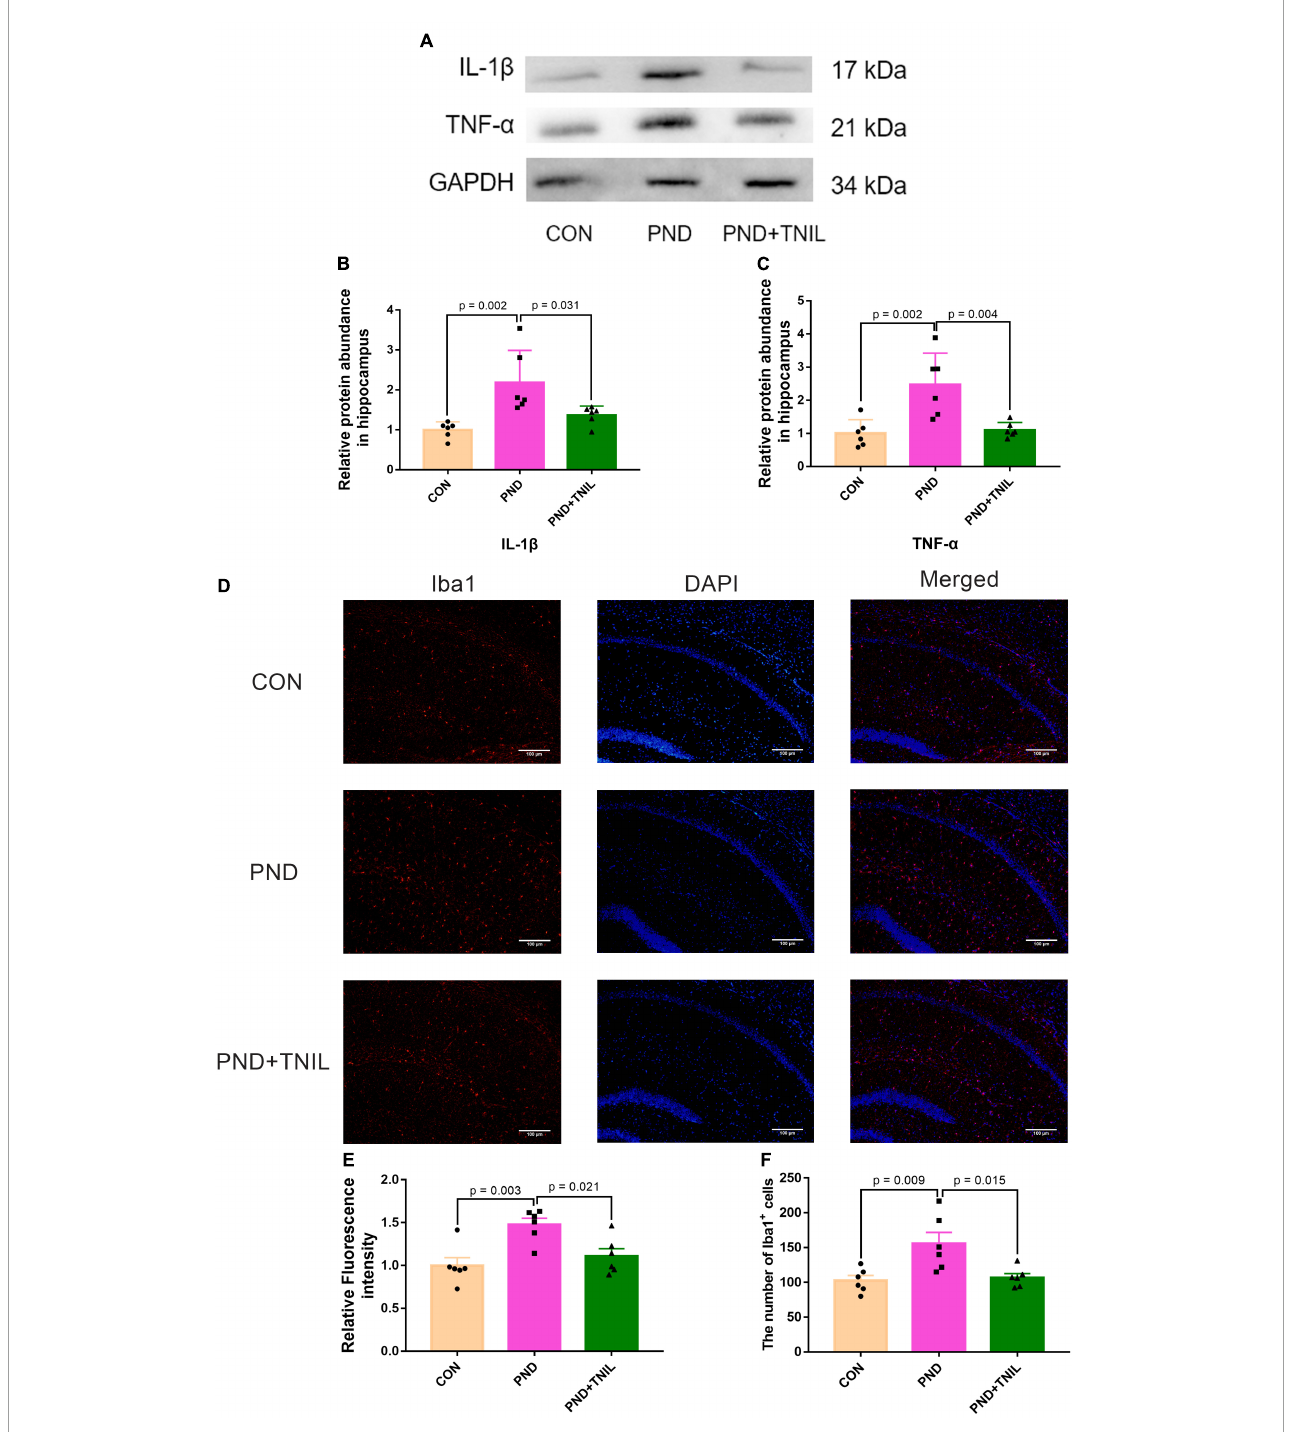
FIGURE3 Transcranial near-infrared laser alleviated hippocampus neuroinflammation of PND mice. (A) Representative Western blots of IL-1 β and TNF- α . (B,C) Relative protein expressions of IL-1 β and TNF- α , normalized to that of the GADPH internal control. (D) Representative images of Iba1 in the hippocampal CA1 region. (E) Quantification of Iba1 relative fluorescence intensity. (F) Quantitative analysis of Iba1 + cells. Scale bar = 100 µ m. Data are shown as mean ± SEM ( n =